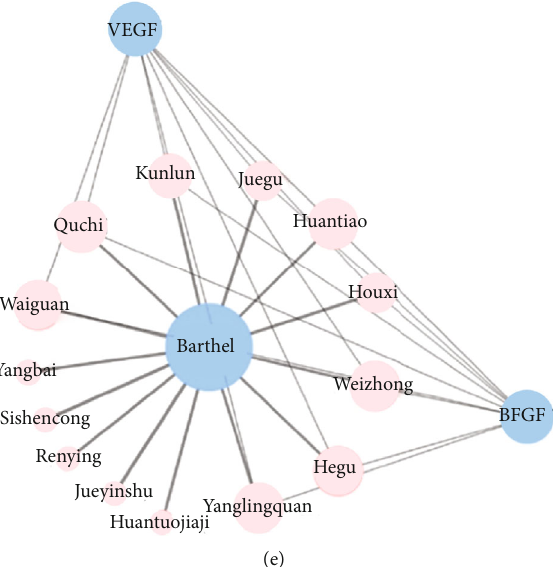
Figure 11: Analysis diagram of ACU-index network relationship.